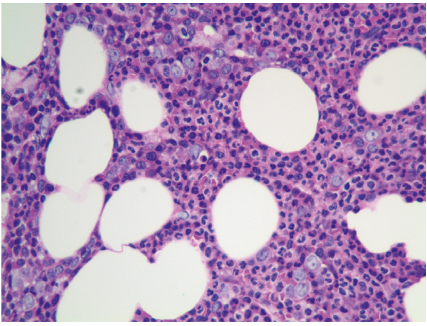
Figure 1: Bone marrow